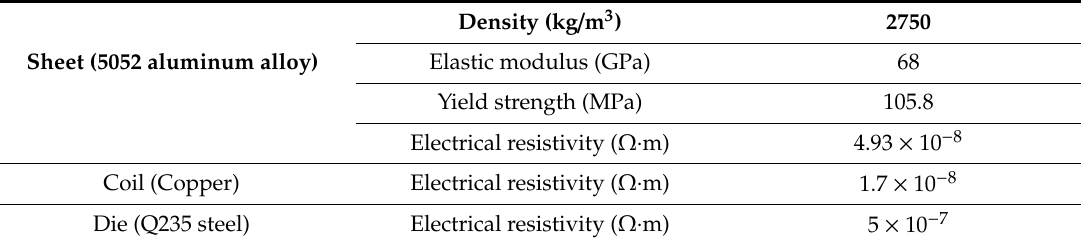
Table 1. Materials parameters of forming system.